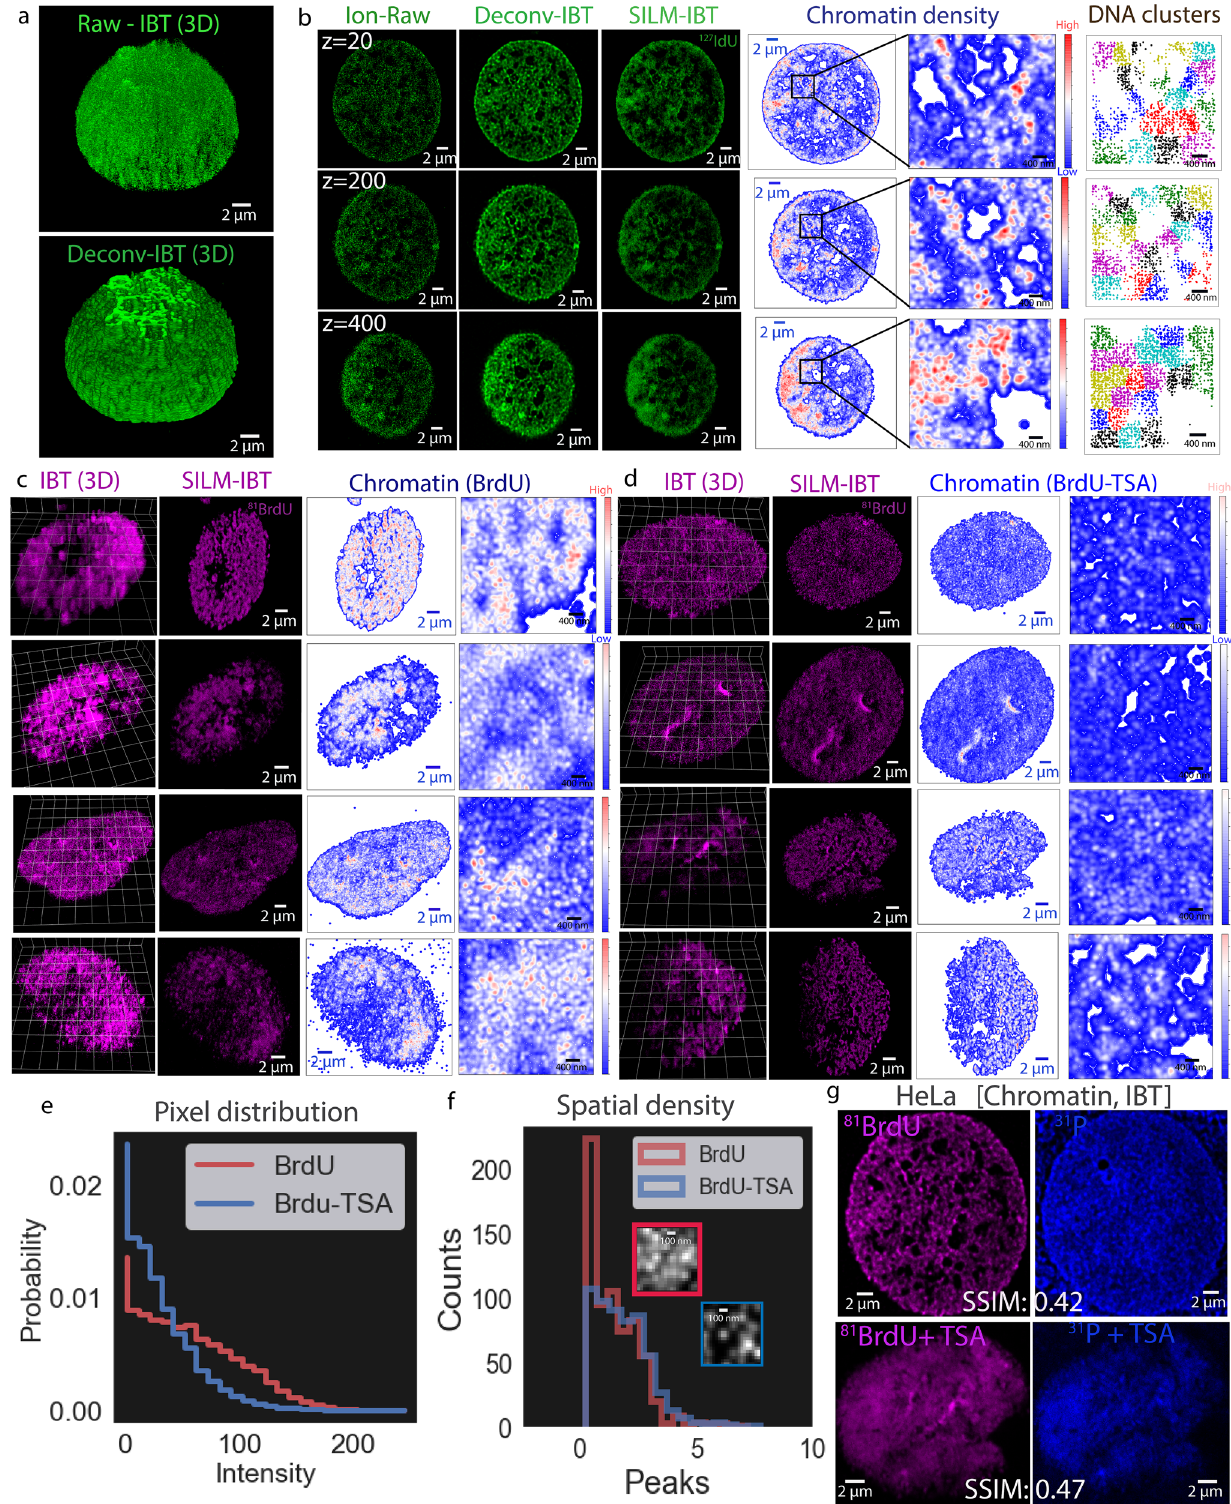
more decondensed chromatin compared to the Nalm6